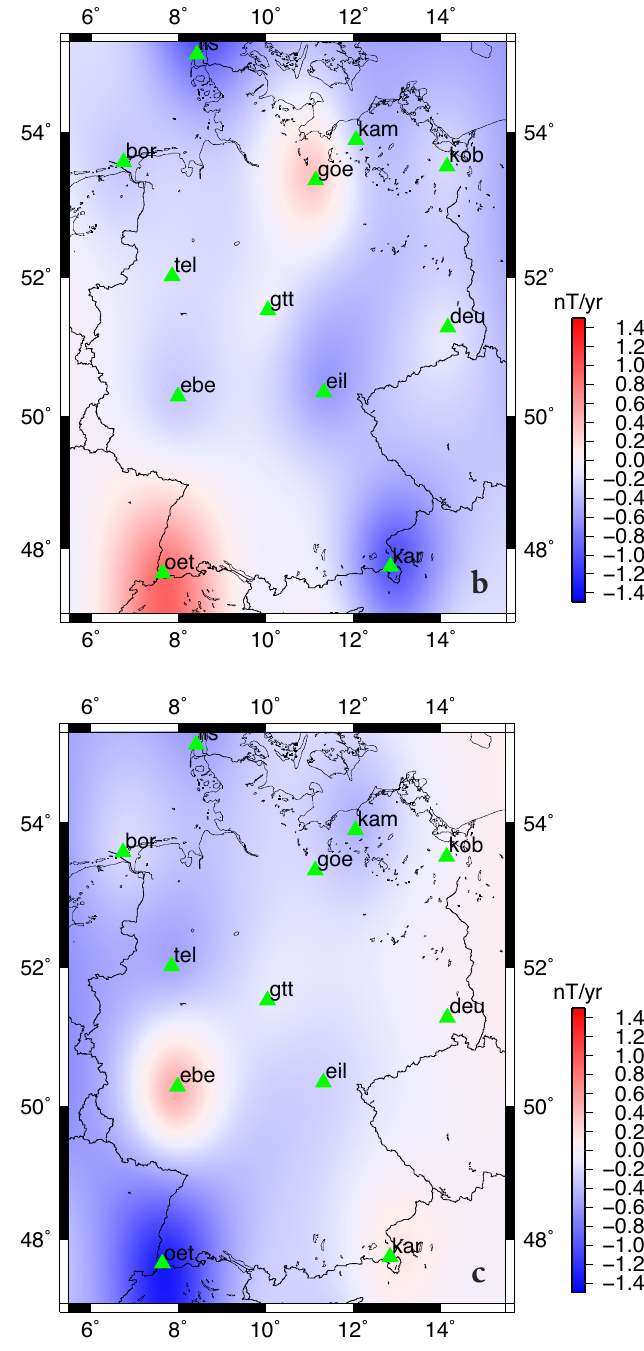
Figure 4. Visualization of repeat stations with negative and positive trends in crustal biases for a) the North (X), b) the East (Y) and c) the vertical (Z) component. Note that detected trends might not be significant and those that are might be much more localized than this figure suggests. See text for more